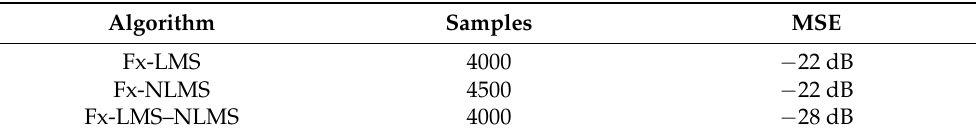
Table 2. Comparative table of